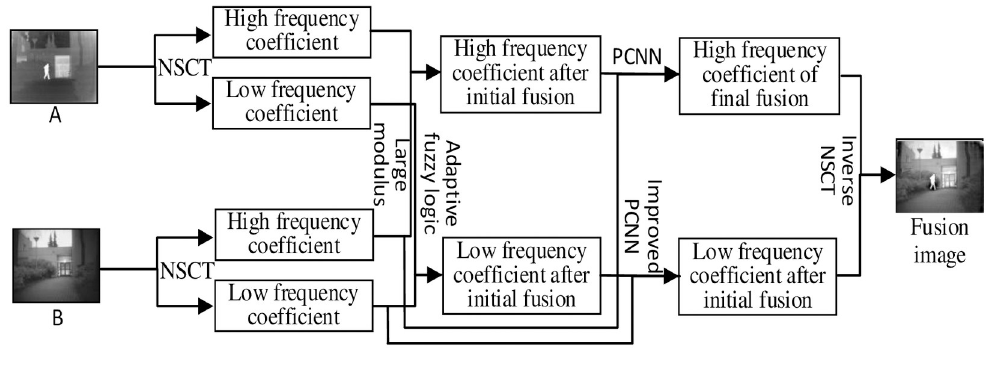
Fig 4. Fusion process